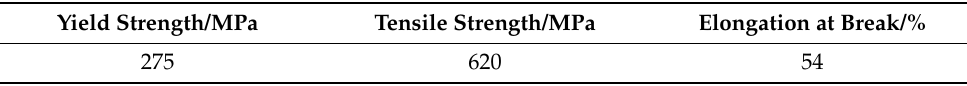
Table 2. Mechanical properties of AISI 304 provided by the manufacturer.